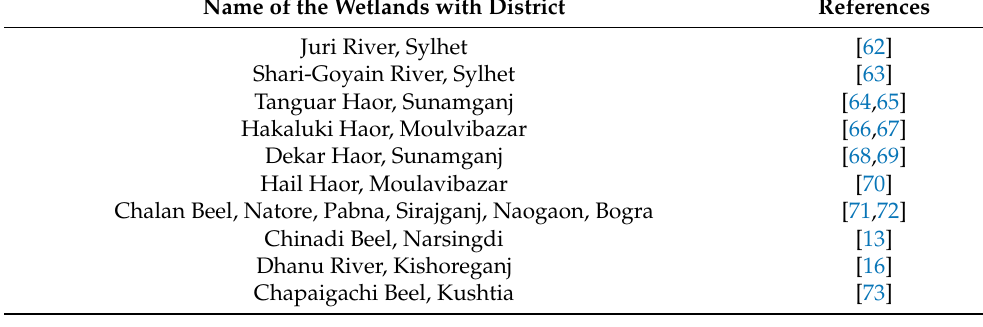
Table 2. Cont. Name of the Wetlands with District